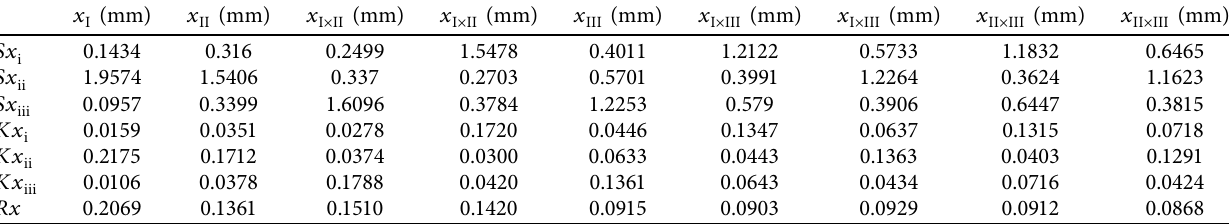
Table 6: Elaboration of the supports’ position